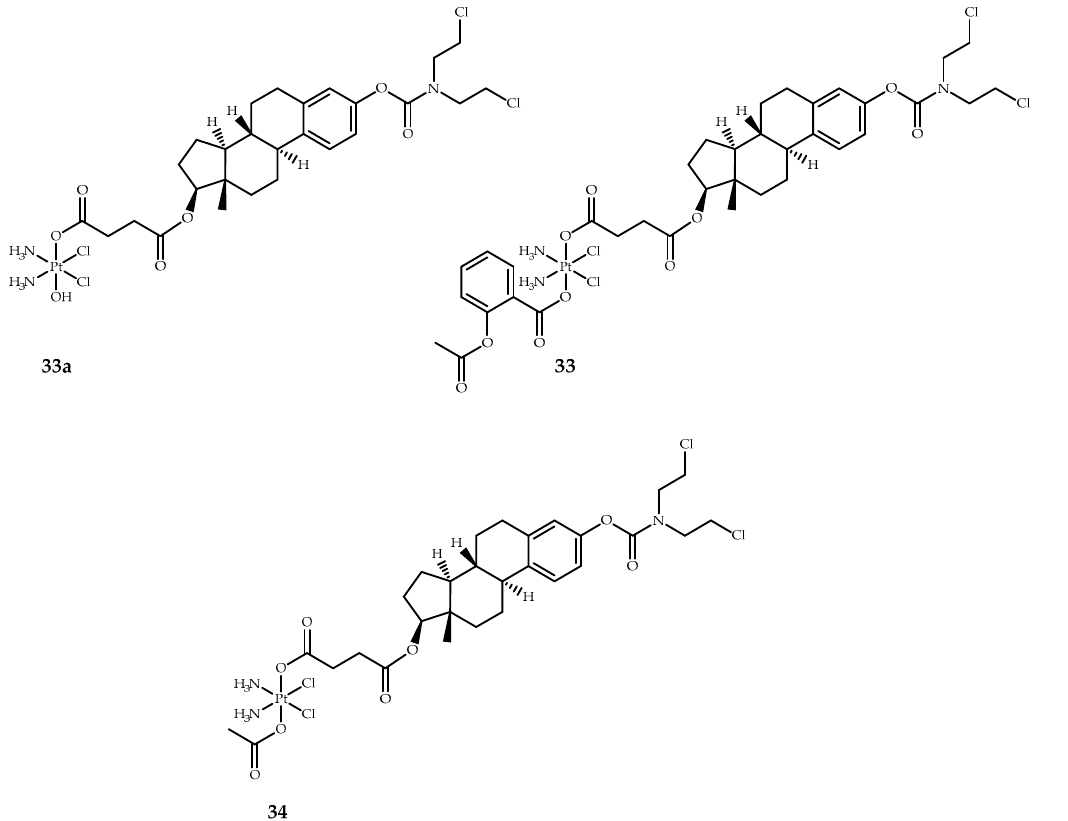
Figure 14. Cisplatin-based platinum(IV) prodrugs 33a, 33 , and 34 with an estramustine moiety in the axial position. Prodrug 33 contains an aspirin moiety in the axial position. Table 18. Antiproliferative activity of prodrugs 33a, 33 and 34 on LNCaP (prostate cancer), DU145 (prostate cancer), MDA- MB-231 (triple negative breast adenocarcinoma), MCF-7 (breast cancer), and HCT-116 (colon cancer) cell lines. MCR-5 pd30 (fetal lung normal cell line) was used as a reference. Selectivity index (SI) = IC 50 MCR-5 pd30/average IC 50 (LNCaP and DU145).